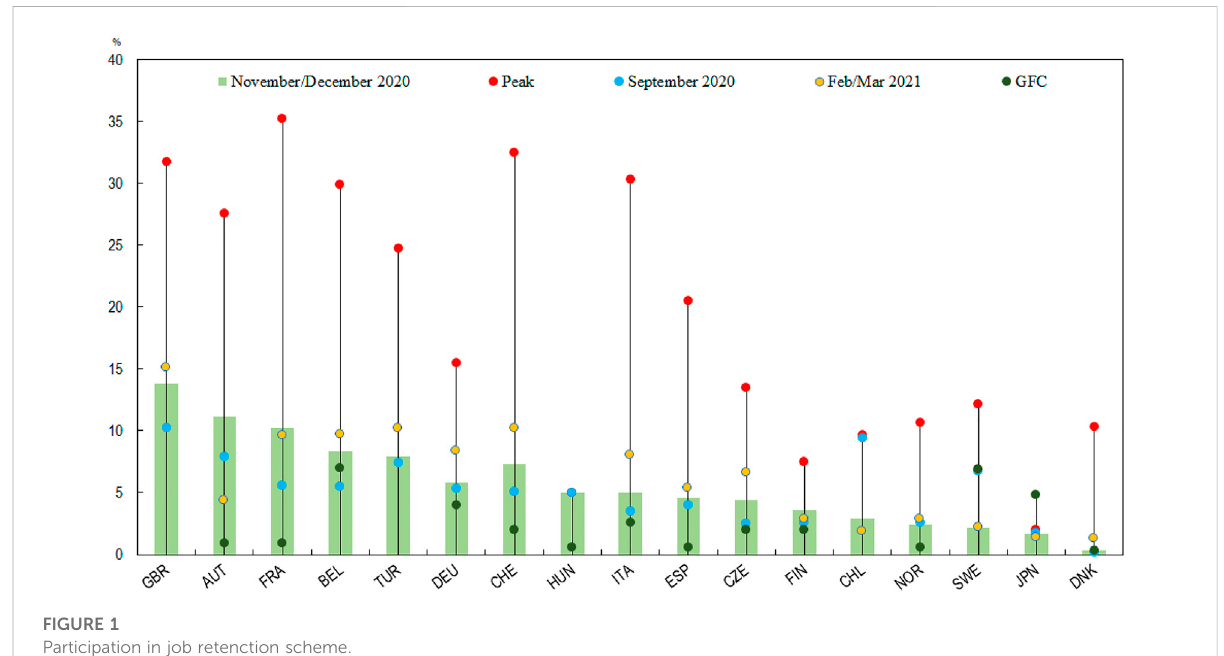
Participation in job retenction